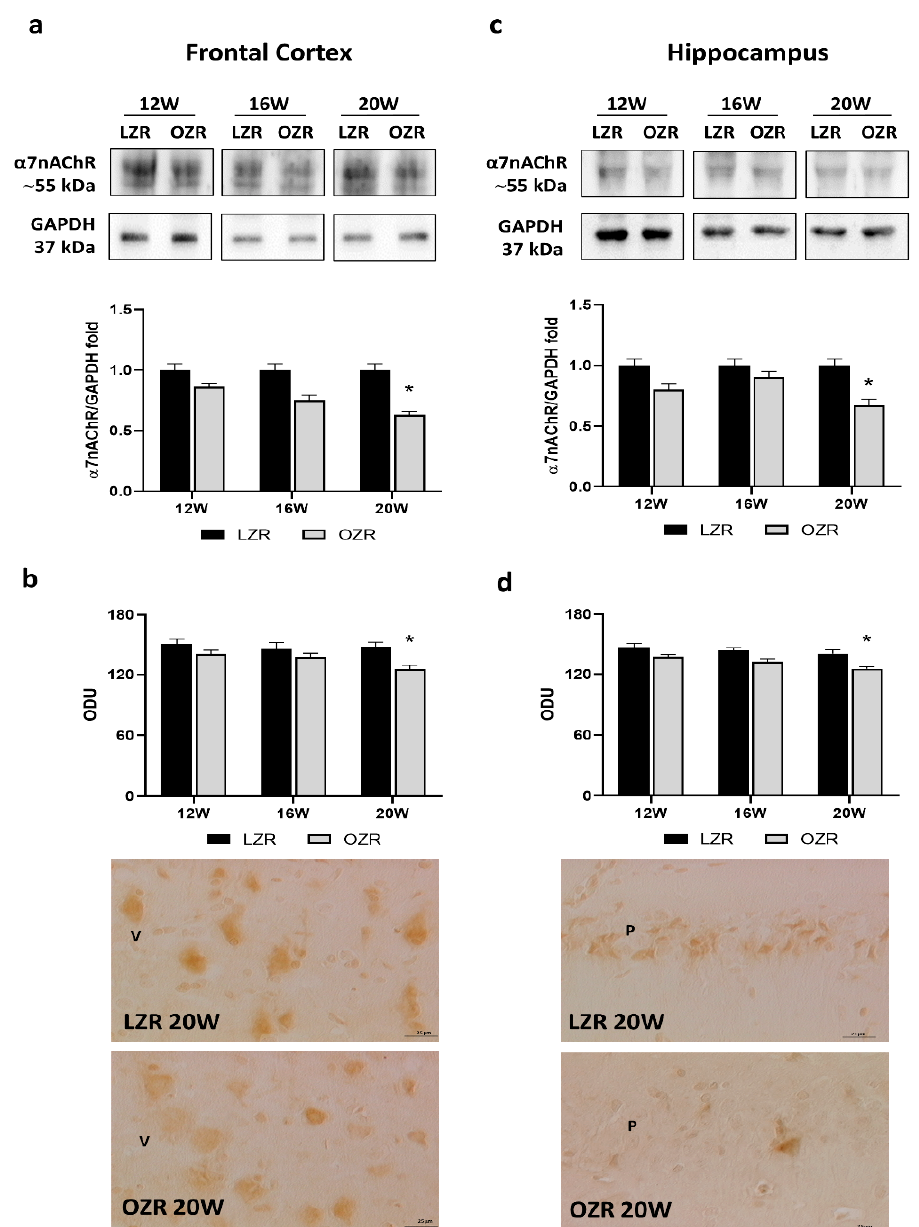
Figure 2. Immunoblotting and immunoreaction of alpha7 nicotinic acetylcholine receptor ( α 7nAChR). Lysates of frontal cortex ( a ) and hippocampus ( c ) from lean Zucker rats (LZRs) and obese Zucker rats (OZRs) at the age of 12, 16, and 20 weeks were immunoblotted using specific anti- α 7nAChR. Bar graphs indicate the densitometric analysis using LZRs as control, and GAPDH levels were used as loading control. Blots are representative of one of three separate experiments; intensity values of α 7nAChR immunostaining in the frontal cortex ( b ) and the hippocampus ( d ) from LZRs and OZRs at the age of 12, 16, and 20 weeks measured in optical density units (ODUs). Data are mean ± S.E.M. * p < 0.05 vs. age-matched LZR. Representative pictures of 20 weeks old LZR and OZR in frontal cortex ( b ) and hippocampus ( d ). V: the fifth layer of the frontal cortex. P: pyramidal neurons of the hippocampus. 40 × magnification. Calibration bar: 25 µm.